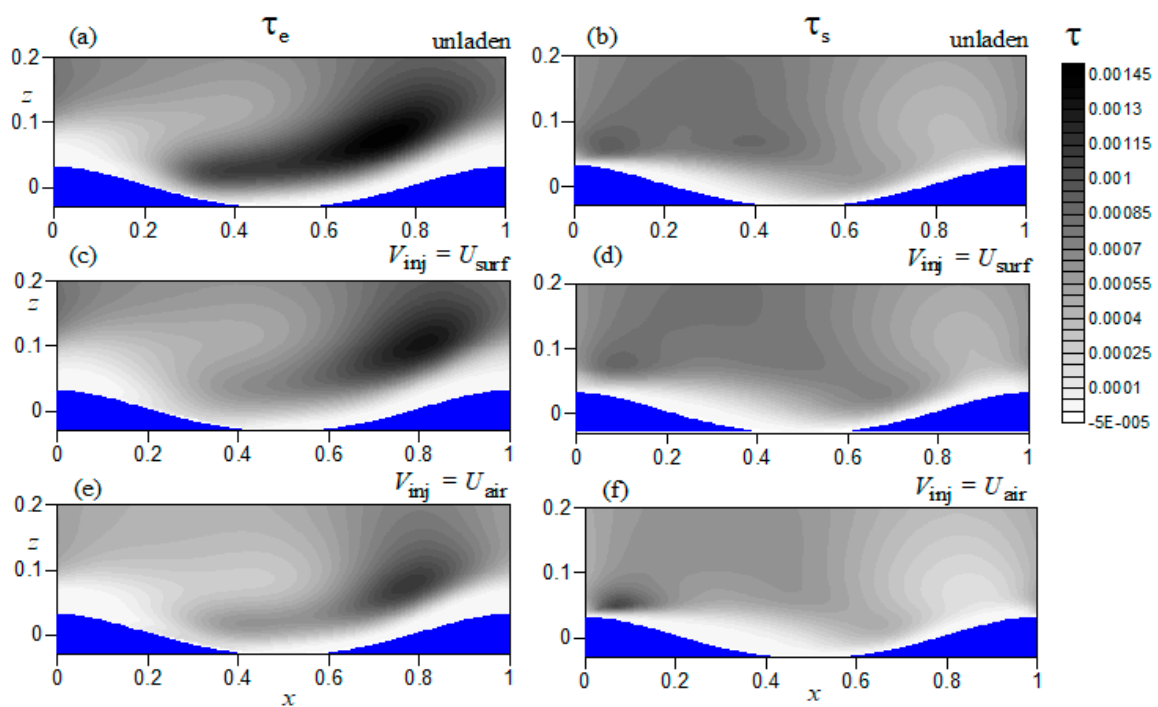
Figure 6. Phase-averaged stresses, τ e and τ s (left and right), obtained for wave steepness ka = 0.1 in droplet-free (panels a , b ) and droplet laden flows with different injection scenario ( V inj = U surf , panels c , d , and V inj = U air , panels e , f ).